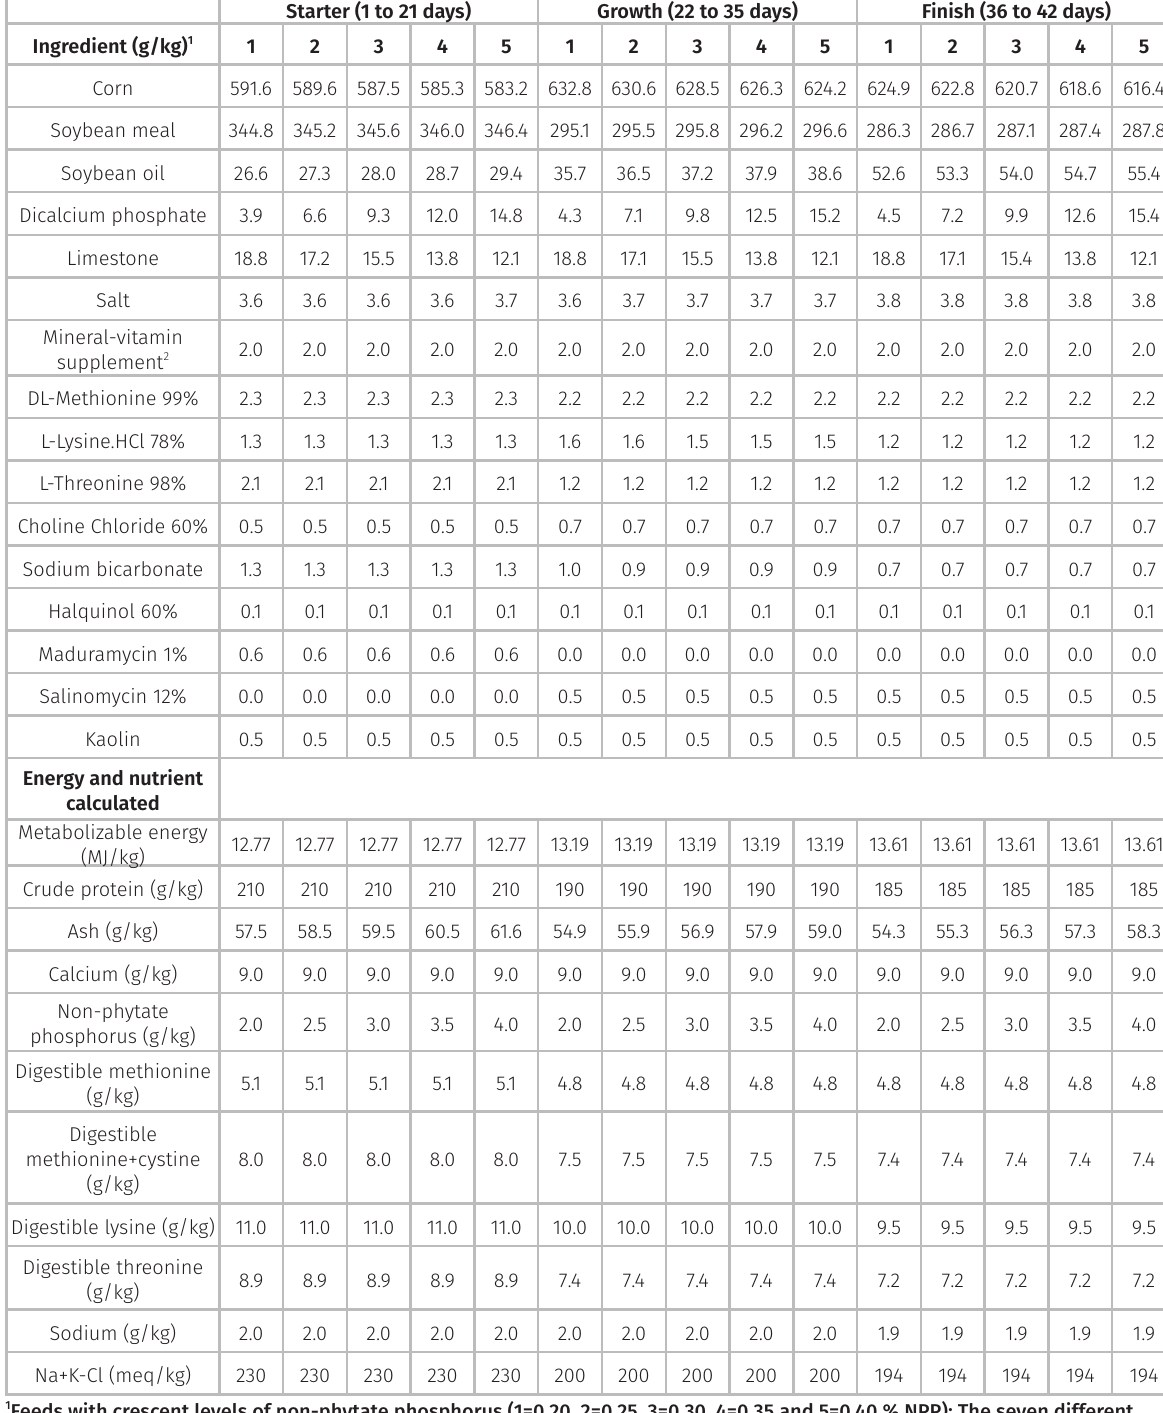
Table I. Diets composition (g/kg as feed basis) and nutritional levels of the experimental diets used within the age periods from 1 to 21, 22 to 35 and 36 to 42 days. Starter (1 to 21